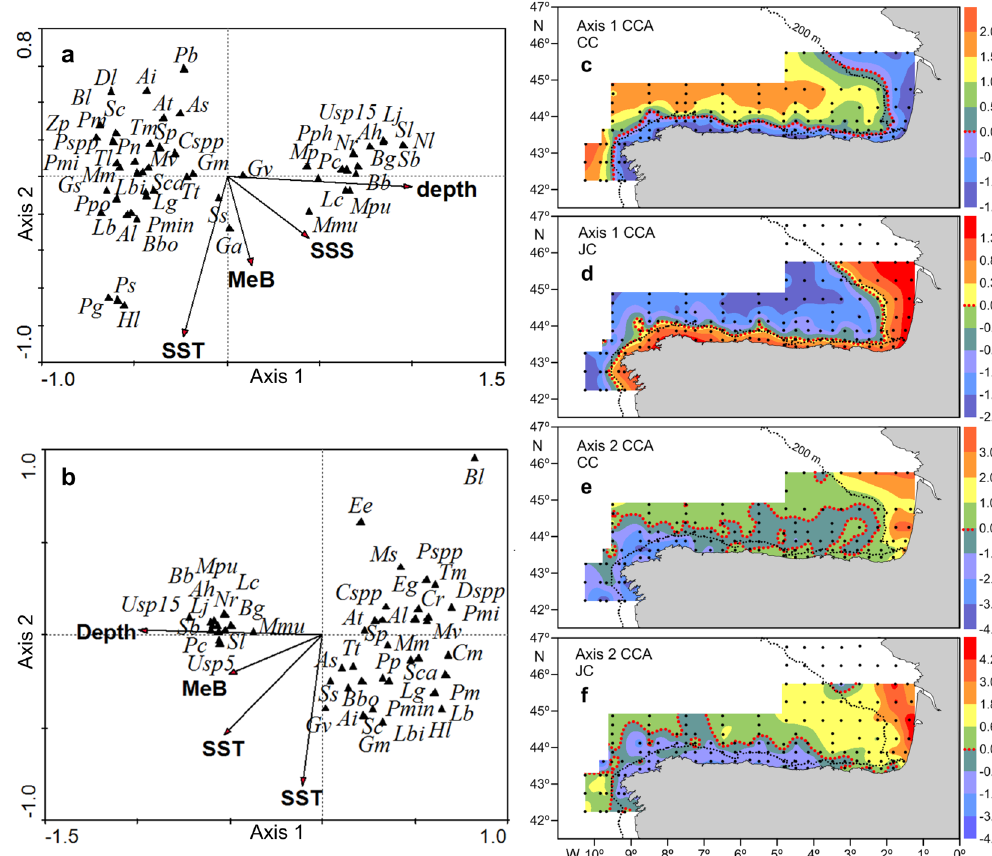
Figure 7. Canonical correspondence analysis (CCA) biplot for environmental variables (arrows) and larval fish taxa (triangles) for: ( a ) CAREVA cruise (CC) and ( b ) JUREVA cruise (JC). Environmental variables were depth (Depth), sea surface temperature (SST, temperature °C at 5 m depth), sea surface salinity (SSS, salinity at 5 m depth) and mesozooplankton biomass (MeB, mg m − 2 ). See Table I for larval fish taxon codes. Geographical distribution of CCA axis sample (station) scores for: ( c ) Axis 1 CC; ( d ) Axis 1 JC; ( e ) Axis 2 CC; ( f ) Axis 2 JC. Dotted redlines separate stations with positive and negative station scores. Black dots represent sampling